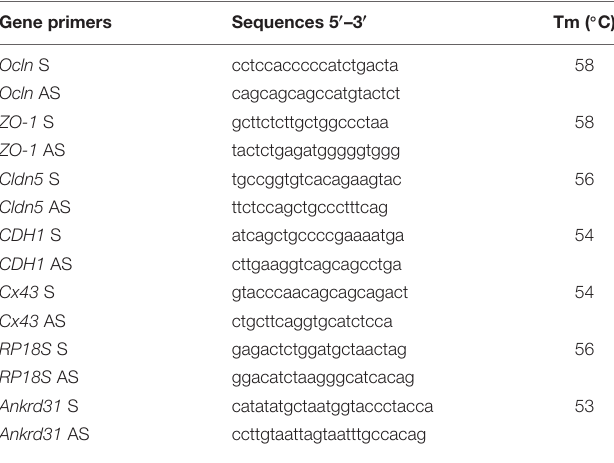
TABLE 1 | Primer sequences and annealing